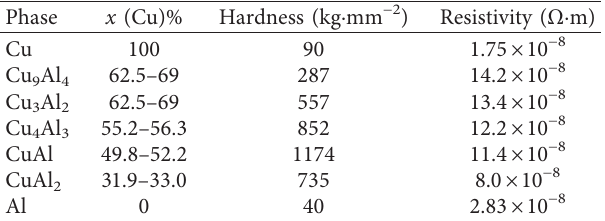
Table 3: The hardness and resistivity of Al, Cu, and intermetallic